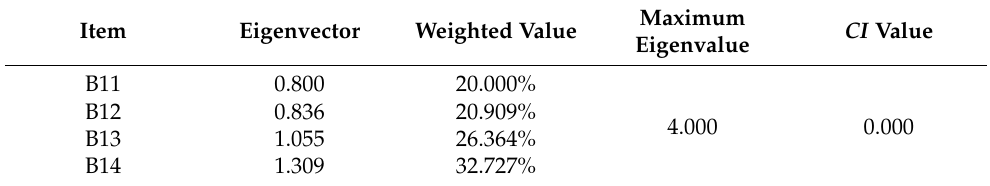
Table 4. AHP layer analysis results.